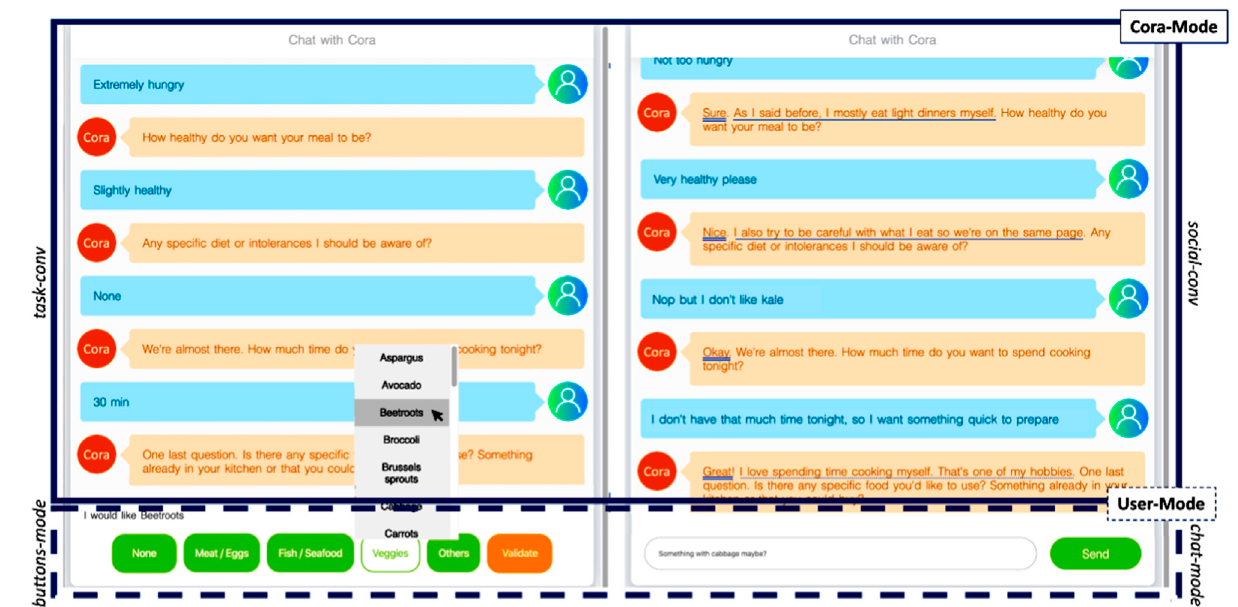
Frontiers in Robotics and AI |